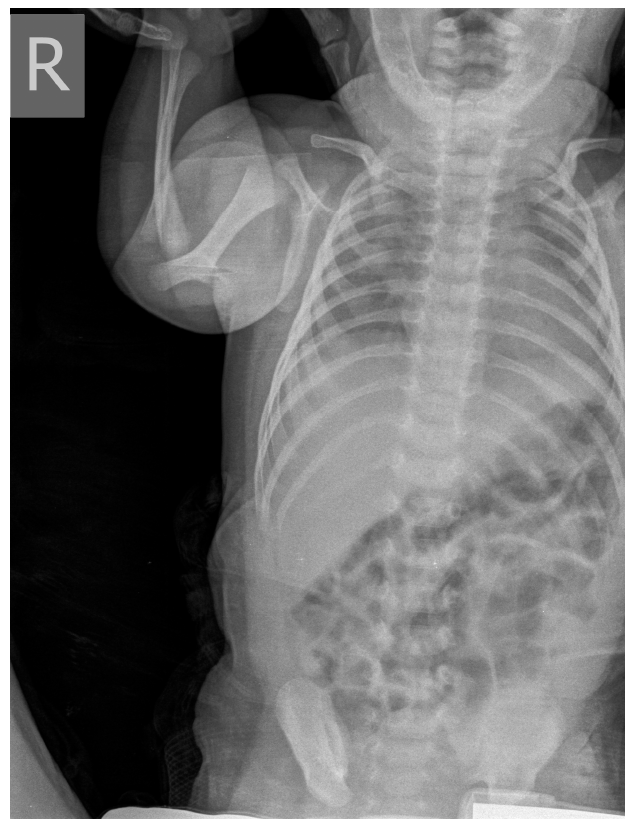
Figure 4. X-ray of thoracic in neonate 2 on the 33rd day of hospitalization: On the right, in the upper and medial lung fields, the transparency of the lung parenchyma is inhomogeneously reduced. On the left, the lower lung field is in superposition with heart shadow. The hemidiaphragms of clear contours.